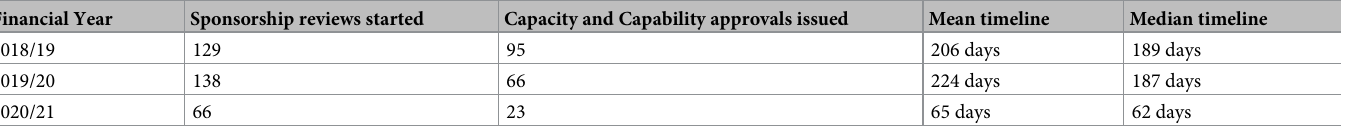
Table 5. Time from sponsorship to issuing capacity and capability approvals (including only non-commercial studies required to complete the full R&D review pro- cess from sponsorship through to capacity and capability